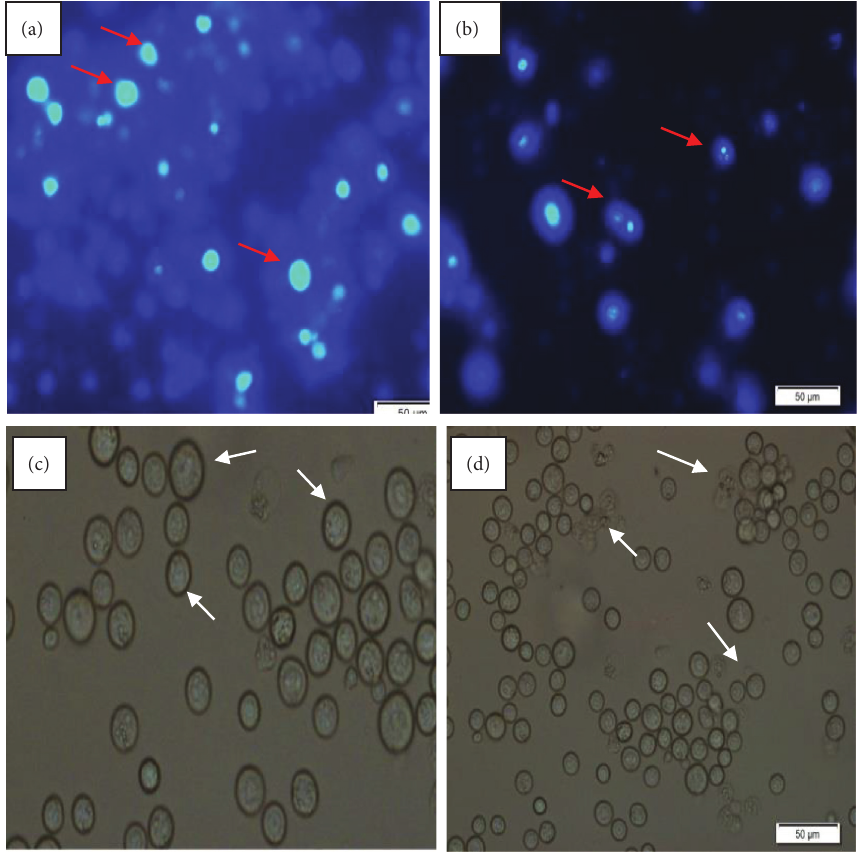
Figure 4: (a-b) Fluorescence and (c-d) optical microscopic observations of EAC cells for control mice and treated mice. (a, b) Fluorescence microscopic view of control and EAF-treated mice cells, (c, d) the optical microscopic view of control and EAF-treated cells, respectively. White (a) and red arrows (c) indicate normal cells. Fragmented cells (apoptotic characteristics) were indicated by red and white arrows in (b) and (d),